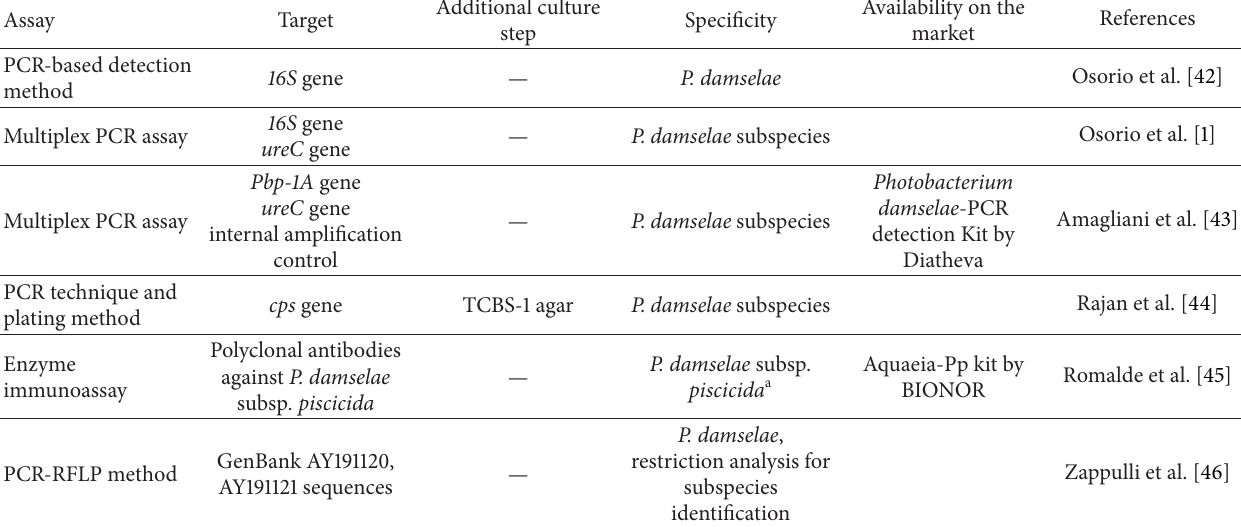
Table 2: Methods for direct identification of Photobacterium damselae subsp.